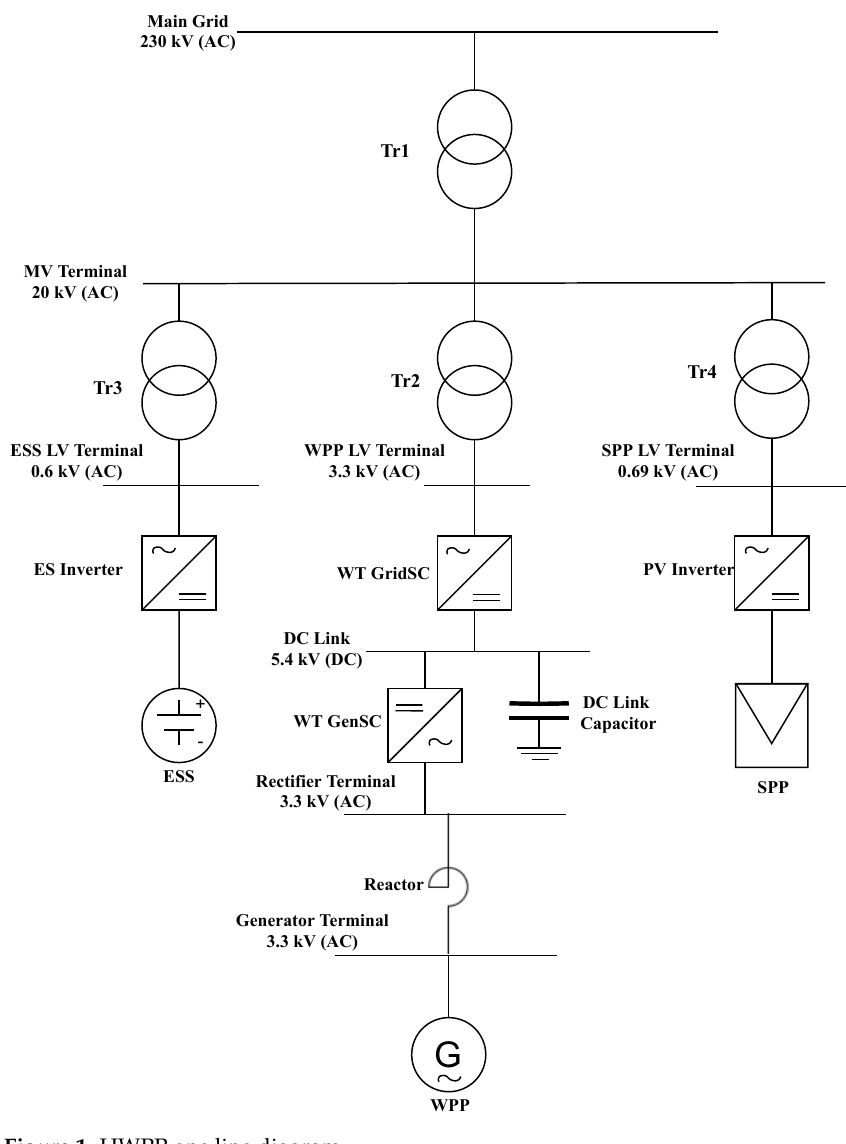
Figure 1. HWPP one line diagram. WPP has been modelled by combining a synchronous generator and a back-to-back converter. The synchronous generator model represents 60 parallel-connected 2 MW Type 4 WTs, which are connected to a generator side AC-DC converter via a shunt reactor. The generator side converter has a rated power of 150 MVA. It works in P-Vac control mode and is connected to the 5.4 kV DC link capacitor. Another 150 MVA DC-AC grid side converter is responsible to deliver power from the DC link to the grid. It works in Vdc-Q mode and is connected to the PCC via a 132 MVA 3.3/20 kV transformer. SPP has been modelled using a built-in photovoltaic system element in PowerFactory. It consists of a current source and a DC-AC converter. The rated power of the SPP is 40 MW and is connected to the PCC via a 45 MVA 0.69/20 kV transformer. ESS has been modelled as a built-in battery storage element in PowerFactory, which contains a 10 MW/20 MWh battery and a DC-AC converter with a rated capacity of 10 MVA. The ESS is connected through a 13 MVA 0.6/20 kV transformer to the